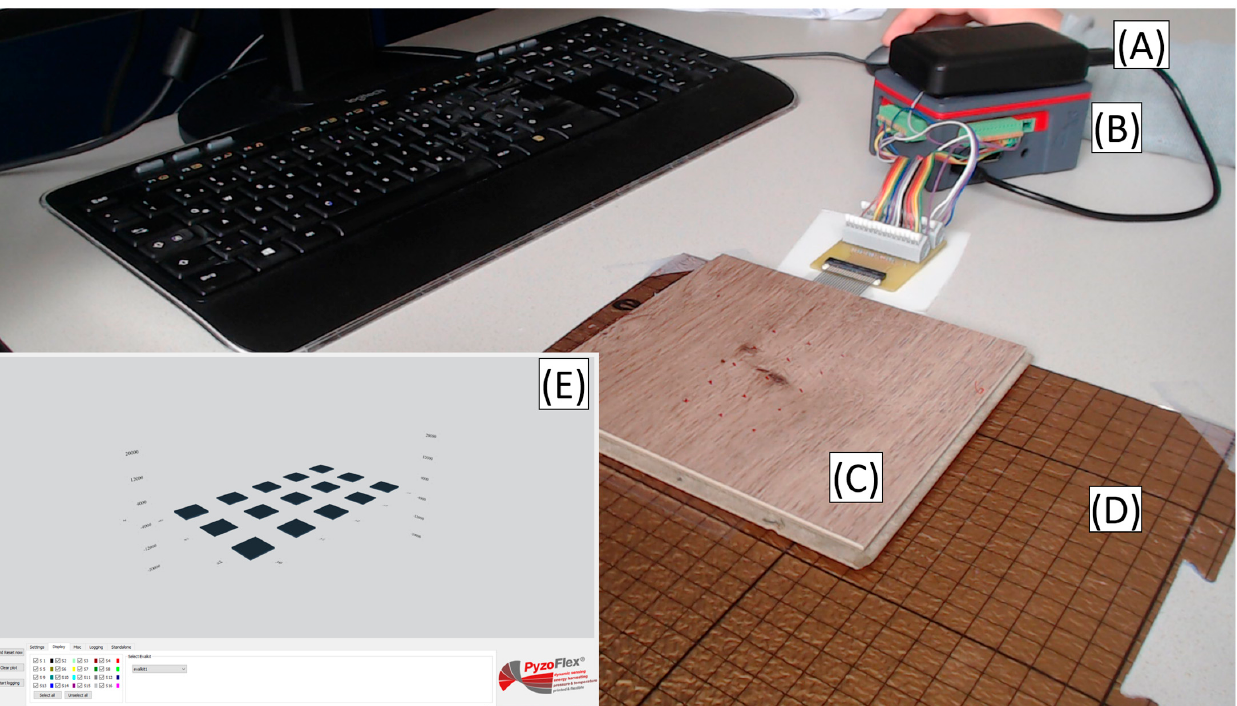
Figure 9. Demonstration setup, consisting of: ( A ) battery, ( B ) 16-channel wireless data acquisition unit, ( C ) smart floor tile, ( D ) underlayment layer, and ( E ) GUI on the PC.